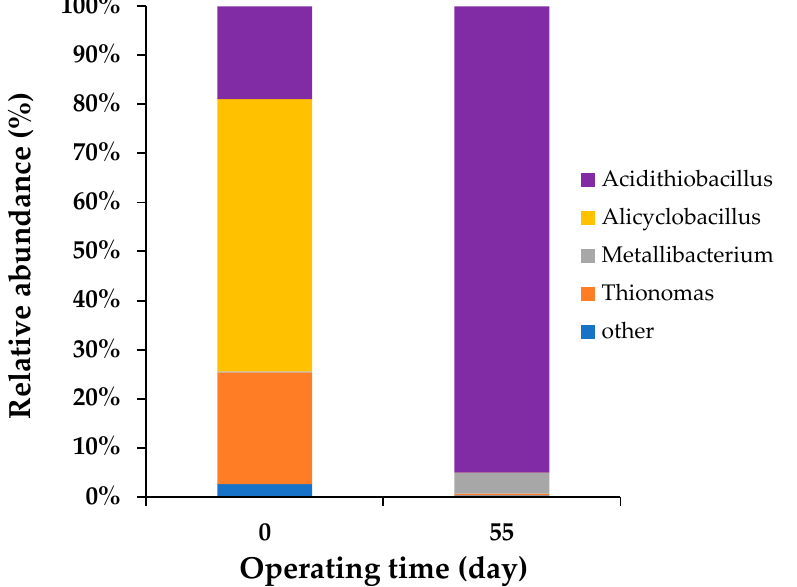
Figure 7. Genus level NGS analysis results for microbial diversity in biotrickling filter using the prokaryotic universal primer. The bar charts show taxonomic profiles obtained at the beginning of experiment (day 0) and after 55 days in operation.